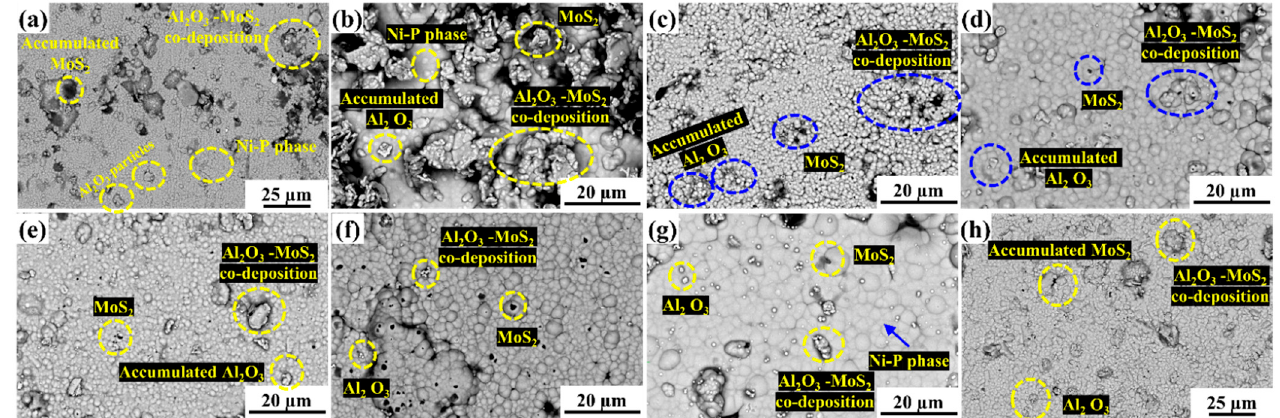
Figure 4. Back-scattered electron microscopy images of composite coating surfaces with ( a ) Al 2 O 3 2 g/L, MoS 2 1 g/L; ( b ) Al 2 O 3 2 g/L, MoS 2 2 g/L; ( c ) Al 2 O 3 3 g/L, MoS 2 0.5 g/L; ( d ) Al 2 O 3 3 g/L, MoS 2 1 g/L; ( e ) Al 2 O 3 3 g/L, MoS 2 1.5 g/L; ( f ) Al 2 O 3 4 g/L, MoS 2 0.5 g/L; ( g ) Al 2 O 3 4 g/L, MoS 2 1g/L; and ( h ) Al 2 O 3 4 g/L, MoS 2 1.5 g/L powder content.